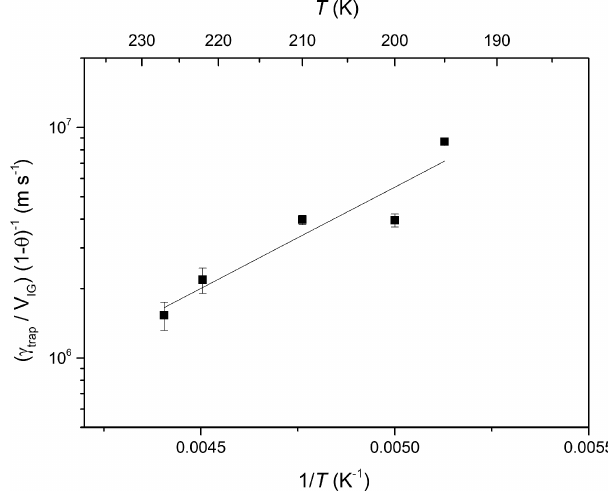
Figure 6. Arrhenius plot of ( γ trap /V IG ) (1- θ ) − 1 derived from data in Fig. 5 versus inverse temperature. The solid line is a least-squares fit to the